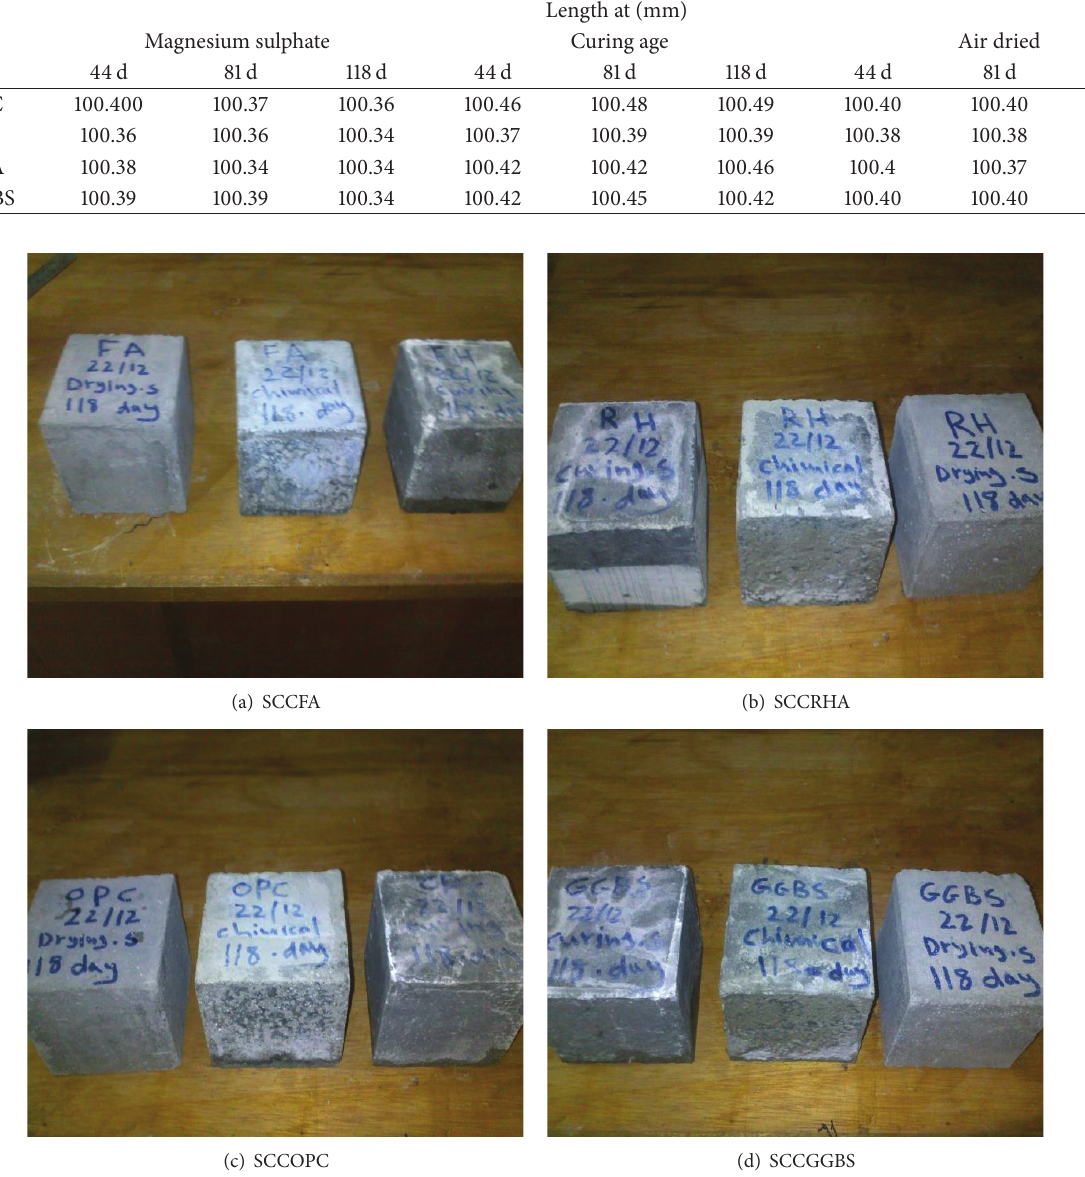
Figure 7: Optical observation of the concrete exposed to MS, water and the drying age of SCC containing various SCM.